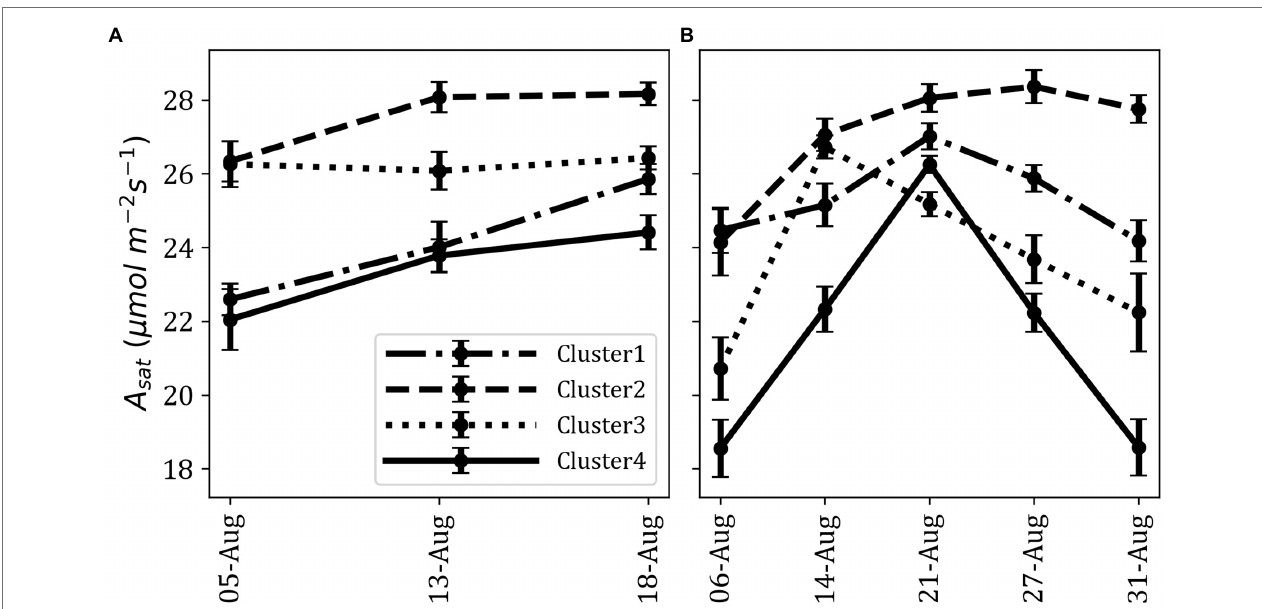
FIGURE 3 | Difference of fluctuation in A sat for each cluster across measurements; average A sat in 2019 (A) and average A sat in 2020 (B) . Data point represents the mean of all members in a cluster. Error bars represent standard error.